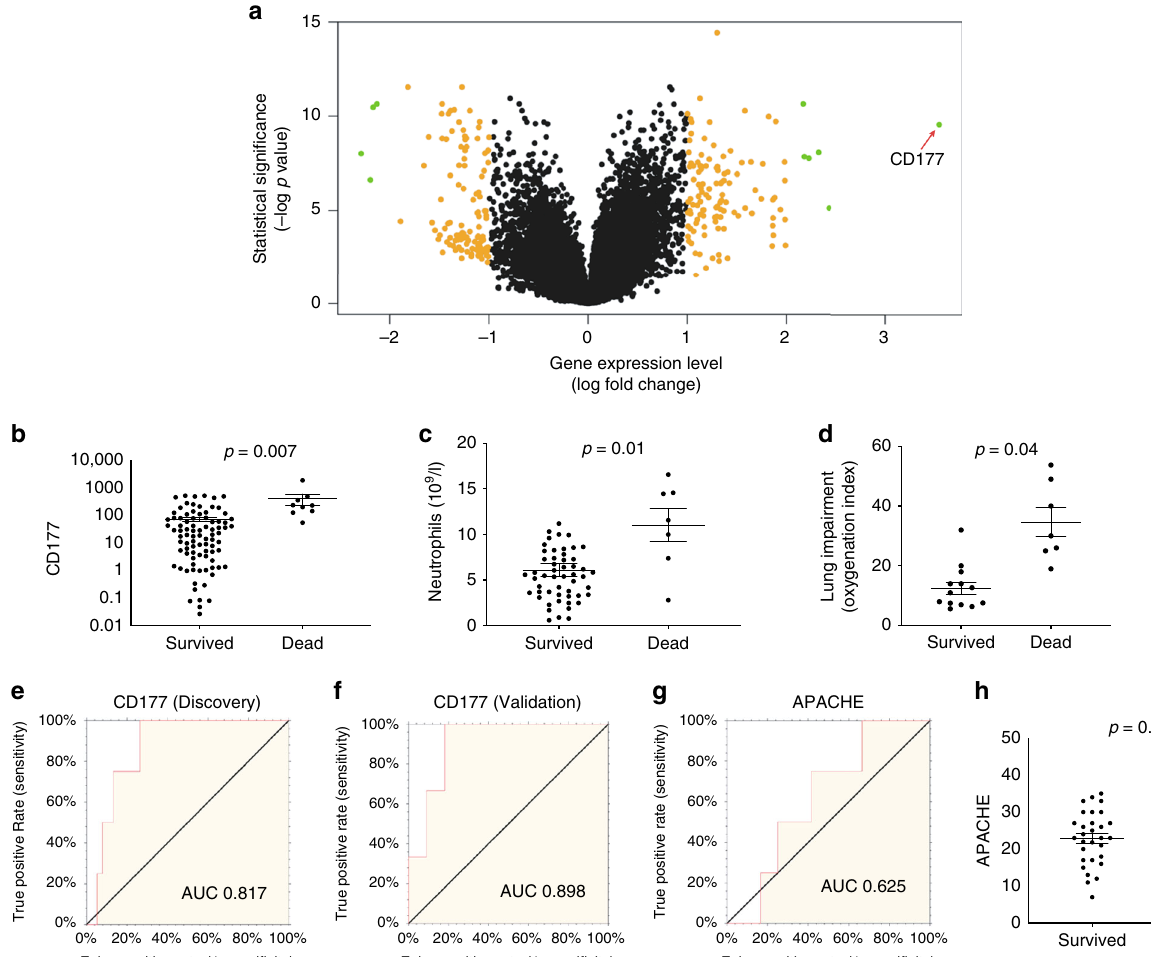
Fig. 7 Neutrophil activity predicts patient outcomes. a CD177 is the most highly differentially expressed gene in severe infection. Volcano plot from microarray analysis (the discovery set) comparing moderate infection ( n = 63) and severe infection ( n = 44); differentially expressed genes are colored. The source data is available in Gene Expression Omnibus (GSE 101702). b CD177 gene expression levels in survivors and nonsurvivors. CD177 gene- expression levels (measured by quantitative real-time PCR in peripheral blood) between survivors and nonsurvivors. c Neutrophil counts in survivors and nonsurvivors. Neutrophil counts in the peripheral blood of severe in fl uenza patients. d Lung impairment in survivors and nonsurvivors. The degree of lung impairment is indicated by the oxygenation index using established method (calculated as inspired oxygen concentration in atmospheric air multiplied by mean airway pressure, divided by partial pressure of oxygen in arterial blood) 45 . A higher oxygenation index indicates more severe lung impairment. e – h Mortality prediction using CD177 expression levels or APACHE scores. Receiver – operator characteristics (ROC) curves of CD177 gene-expression (measured by quantitative real-time PCR) to predict mortality in e the discovery set (95% con fi dence interval: 0.602 – 0.921) and f the validation set (95% con fi dence interval: 0.769 – 0.957). In g , h , APACHE scores are also shown (ROC 95% con fi dence interval: 0.230 – 0.843). APACHE is a clinical mortality risk prediction score composing of age, premorbid comorbidities and acute physiological derangements. b – d , h p Values were calculated by Mann – Whitney U test. Error bars represent means and standard errors. Source data for b – h are provided as a Source Data Excel fi